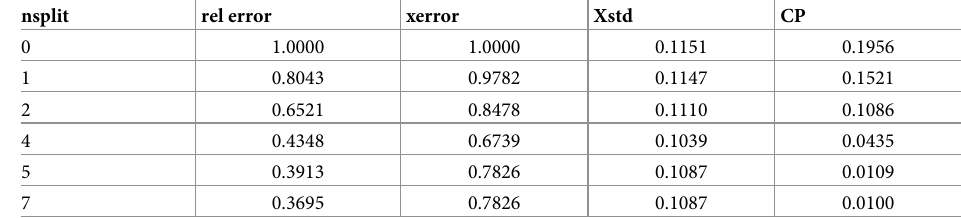
Table 3. Prediction error estimation and complexity parameter CP value of the decision tree model with different splitting